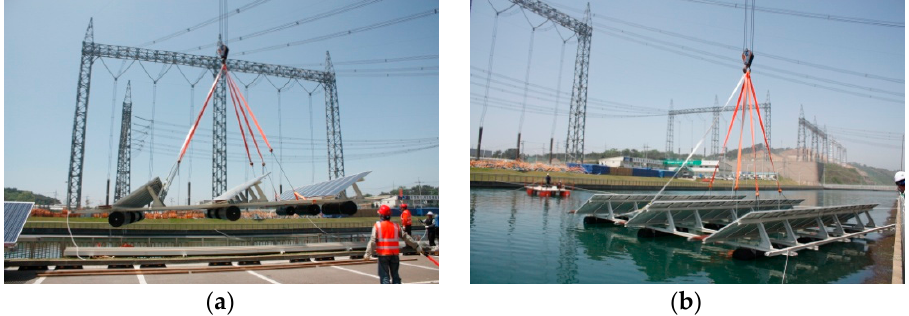
Figure 13. Lifting and launching process; ( a ) Lifting; ( b ) Launching.